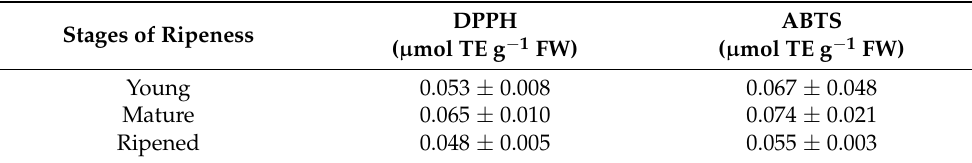
Table 4. Antioxidant activity of different maturity stages of C. moschata polyphenols. Stages of